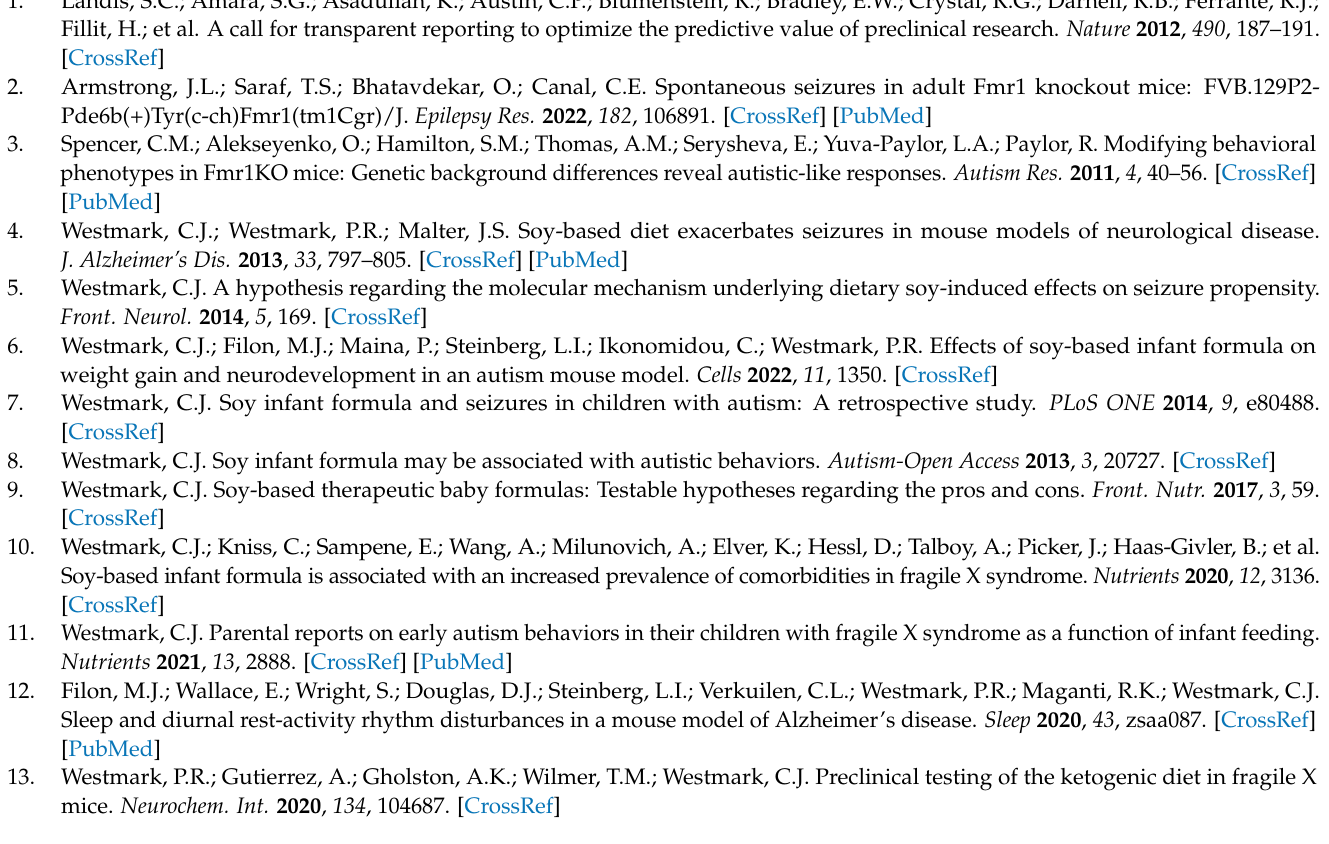
acid levels specific to males; Figure S8: Diet-specific differences in blood plasma amino acid levels in both females and males; Figure S9: Blood plasma essential amino acid levels as an effect of diet; Figure S10: Blood plasma branched chain amino acid levels as an effect of diet; Figure S11: Ratios of blood plasma amino acid levels for ornithine, glutamine and glycine to BCAAs as an effect of diet; Table S1: Amino acid profile